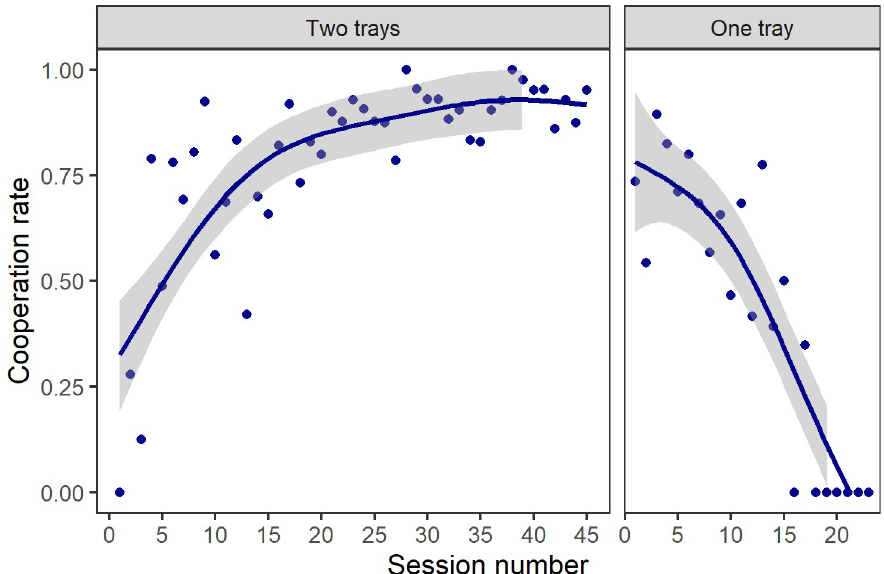
Fig 1. Cooperation rate of Asian elephants in the test under the 2-tray and the 1-tray phase. Cooperation rate was calculated as frequency of successful cooperation divided by frequency of all attempts (i.e., all trials in a session). Each point represents the cooperation rate in each session. Gray areas represent 95% confidence intervals. In the 2-tray Phase I, cooperation was maintained at a high level throughout testing, while cooperation broke down entirely